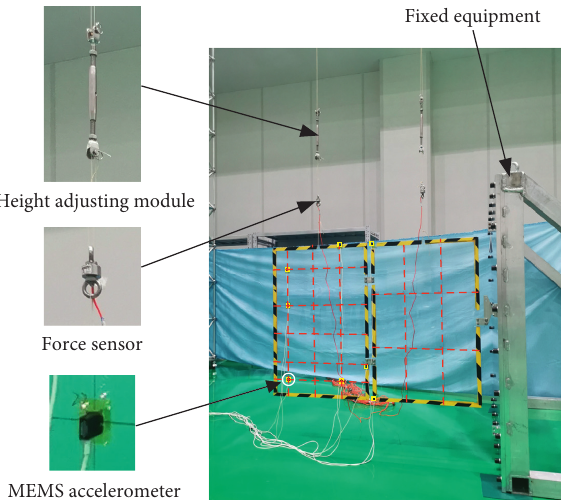
Figure 11: Schematic diagram of the test site.